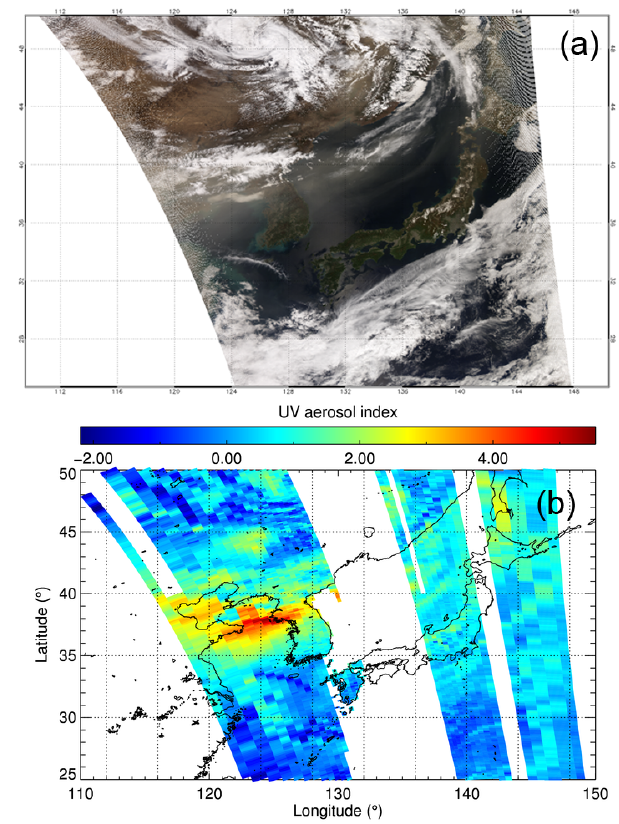
Figure 3. (a) MODIS Aqua true color image and (b) UV aerosol index from the OMI product in northeast Asia on 28 April